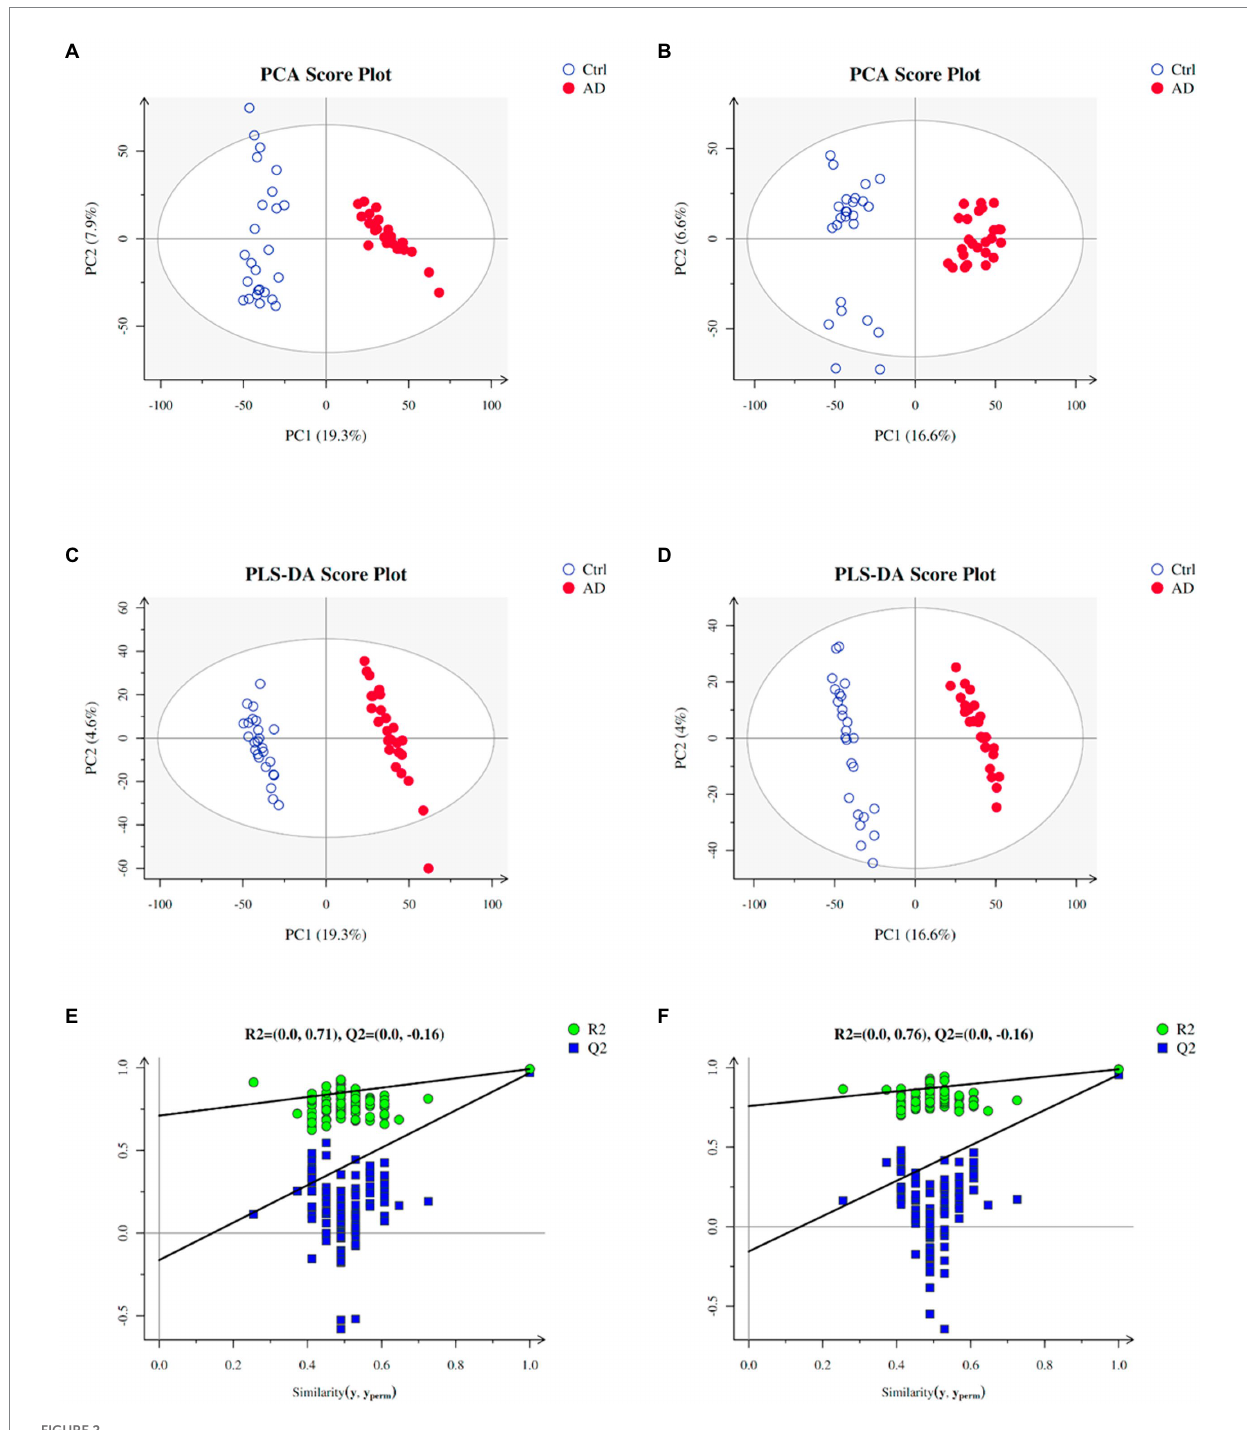
FIGURE 2 Plots of PCA and PLS-DA scores of the training samples. (A) PCA in positive ion mode for the sample. (B) PCA in negative ion mode for the sample. (C) Score plots of PLS-DA in positive ion mode. (D) Score plots of PLS-DA in negative ion mode. (E) A plot of PLS-DA permutation in positive ion mode. (F) A plot of PLS-DA permutation in negative ion mode. To determine that PLS-DA is not overfitting, one of two conditions needs to be met: (1) All blue Q2 points are lower from left to right than the original blue Q2 point, and (2) The regression line of point Q2 is less than or equal to 0 at the intersection of ordinates. Ctrl: control group; AD: alcohol dependence